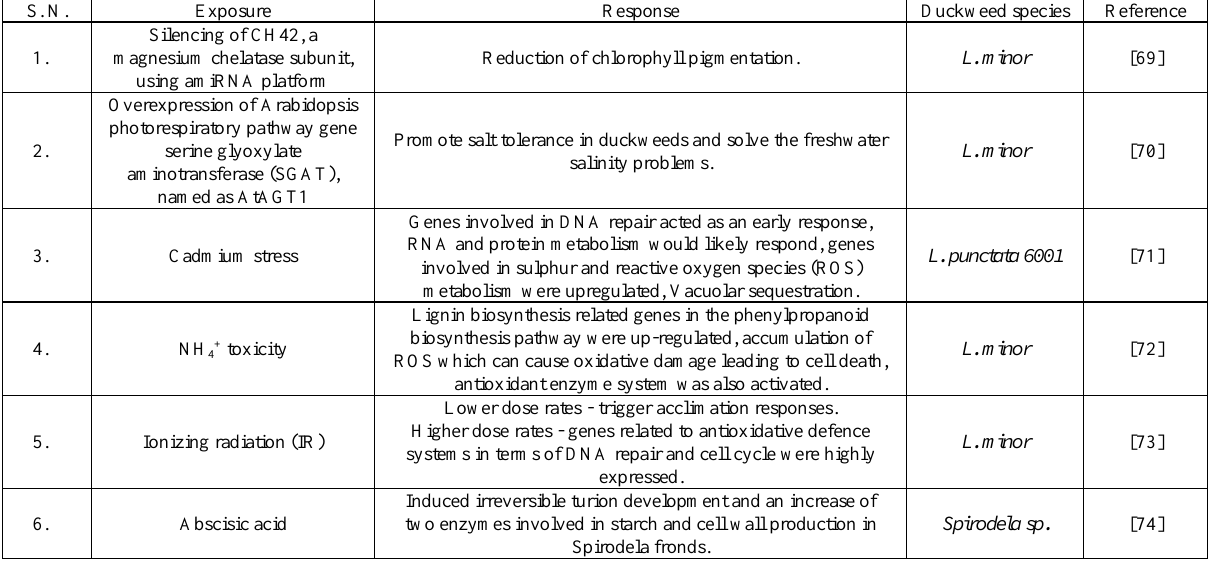
Table 2. Response of duckweed to exposure to different